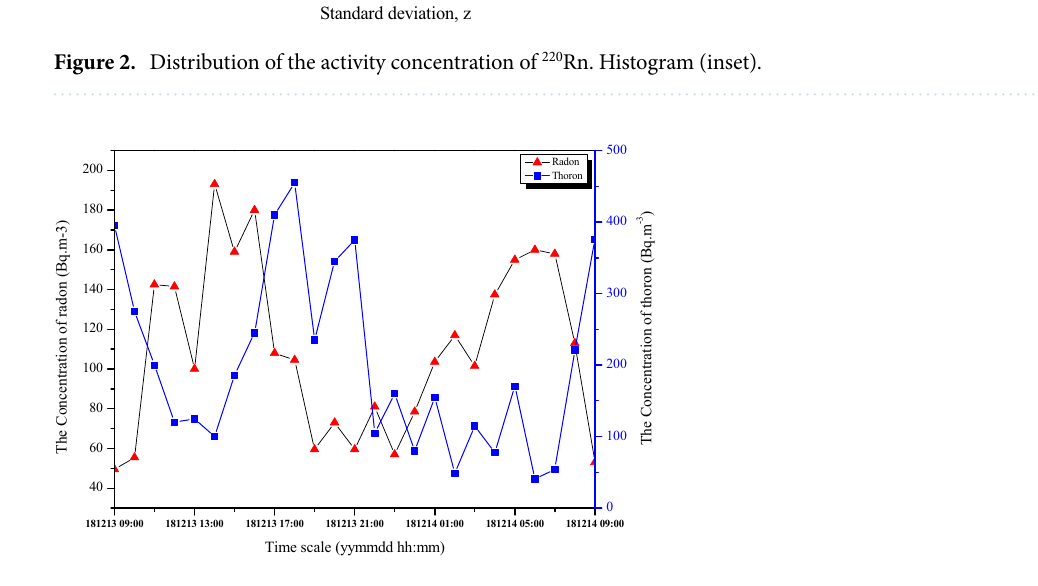
Figure 3. Diurnal variation of indoor radon and